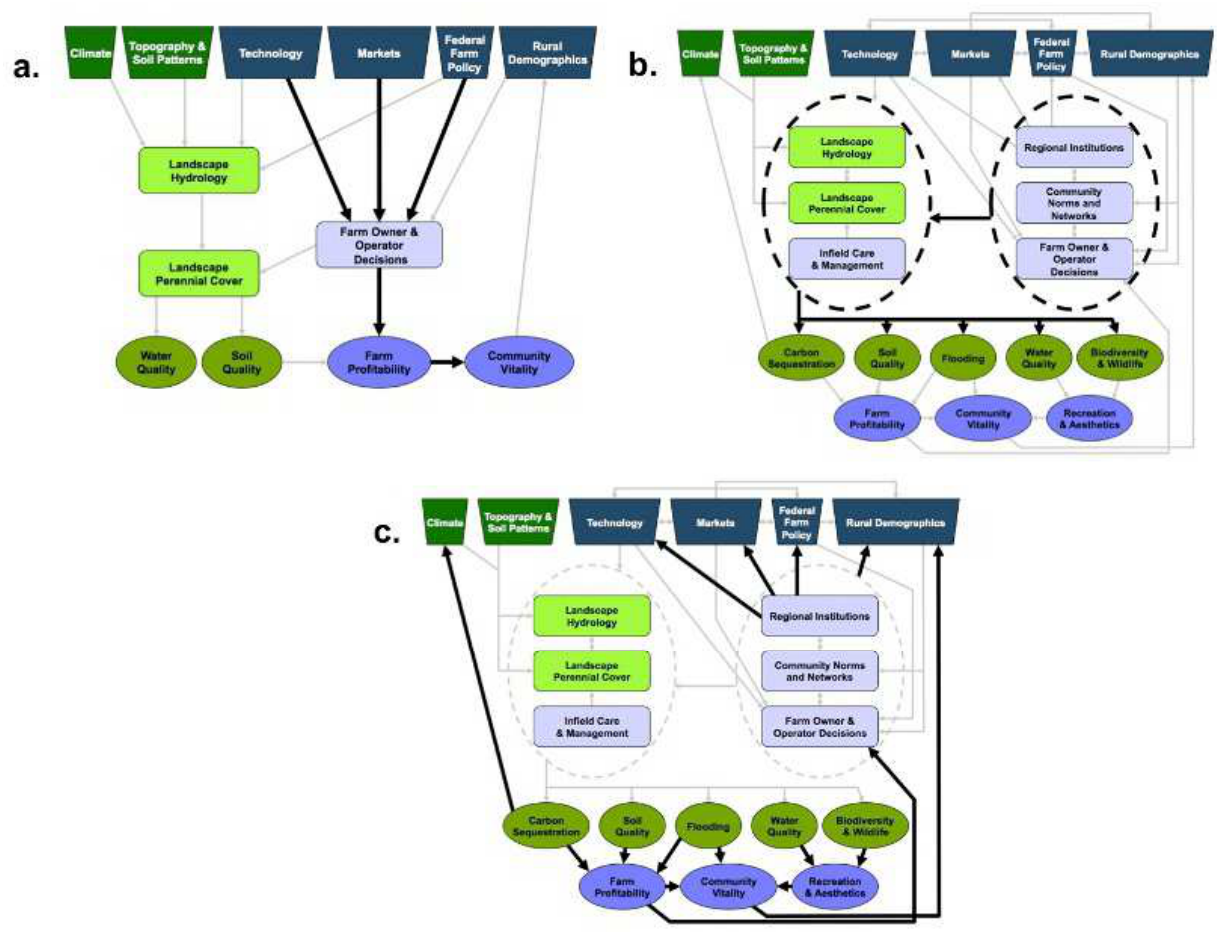
Fig. 4. Three possible future scenarios for Iowa agroecosystems were developed from workshop themes: tweak (4a), adapt (4b), and transform (4c). Scenarios were all built upon the same heuristic model (Fig. 3), but differ in their prioritization of different systemic relationships (gray arrows represent normal relationships; darker arrows represent relationships that are prioritized in a given scenario). In “tweak” (4a), macroscale forces were seen as driving regional outcomes, but beyond regional control. This scenario also omits certain relationships that were seen as being impractical or of little importance by proponents of this scenario. In “adapt” (4b), policies, partnerships, and programs are based on understanding regional social-ecological complexity and are designed to achieve desired multiobjective outcomes. “Transform” (4c) recognizes regional social-ecological system complexity and focuses on directly influencing powerful top-down drivers to catalyze and equip new markets that have the power to reorient the regional system to a desired